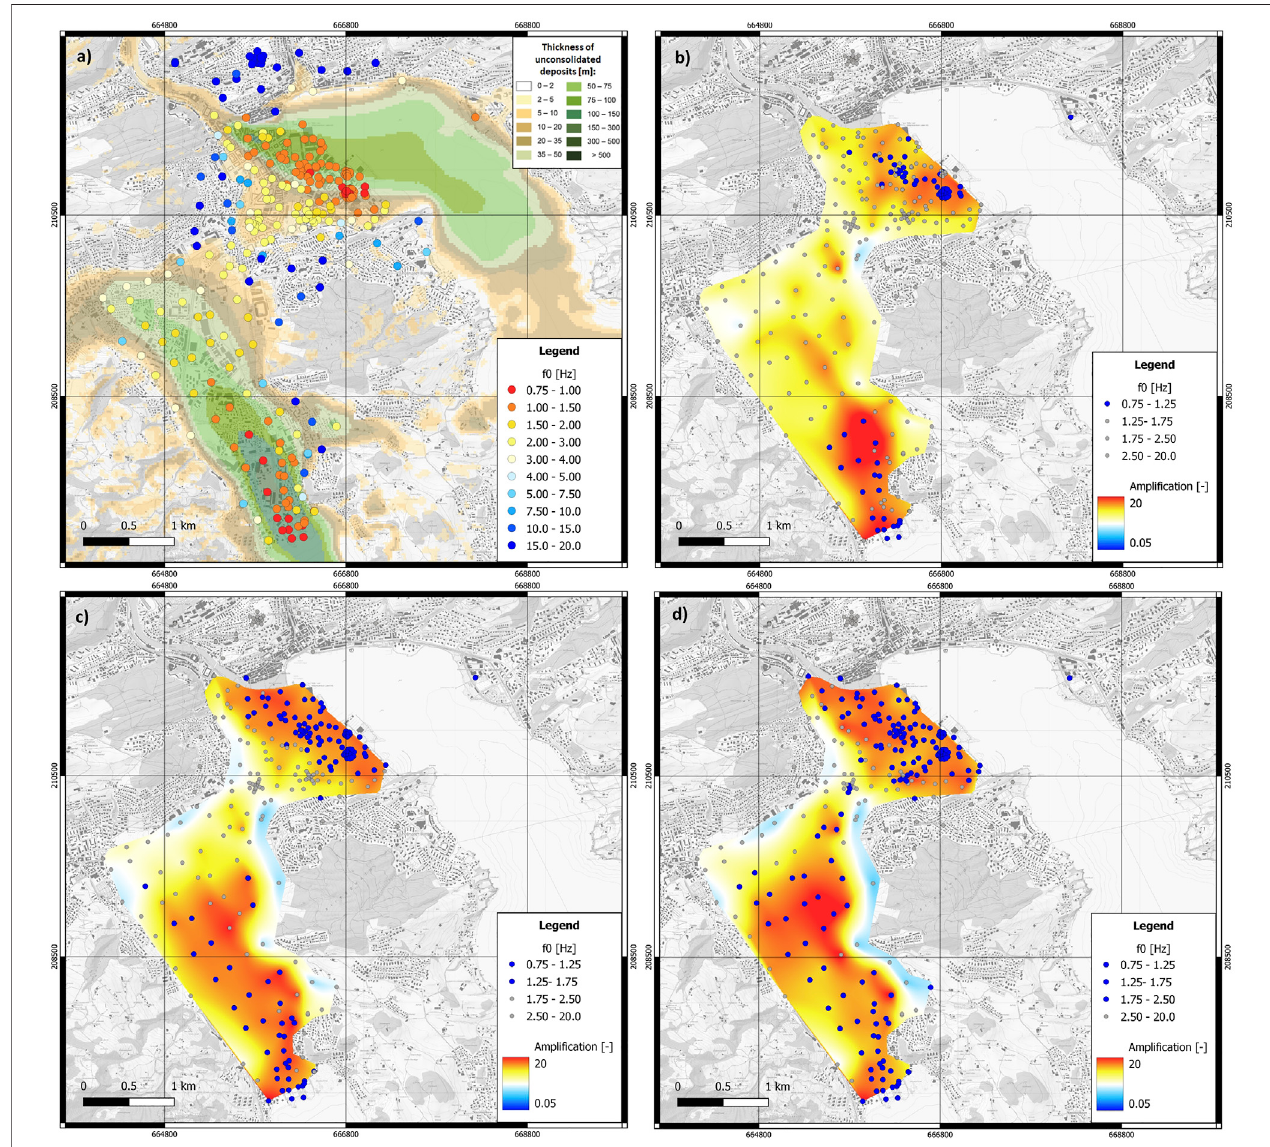
FIGURE 9 | Fundamental resonance frequency f0 for more than 300 points in the Lucerne area compared to (A) the map of the thickness of the unconsolidated deposits, (B – D) ampli fi cation map derived using the SSRh method for 1, 1.5, and 2 Hz, respectively. The reference for ampli fi cation maps is the Swiss reference rock pro fi